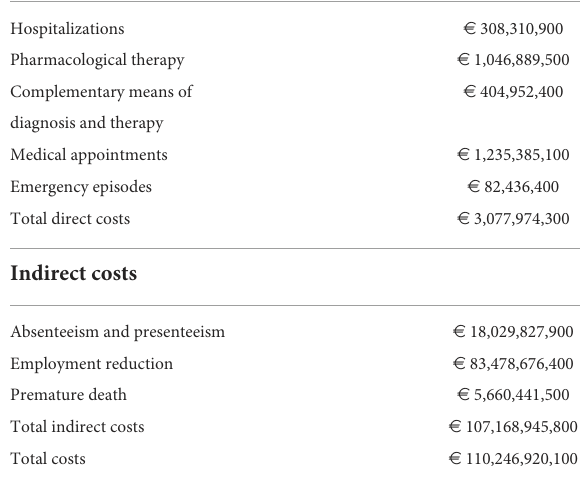
TABLE 6 Summary of direct costs.